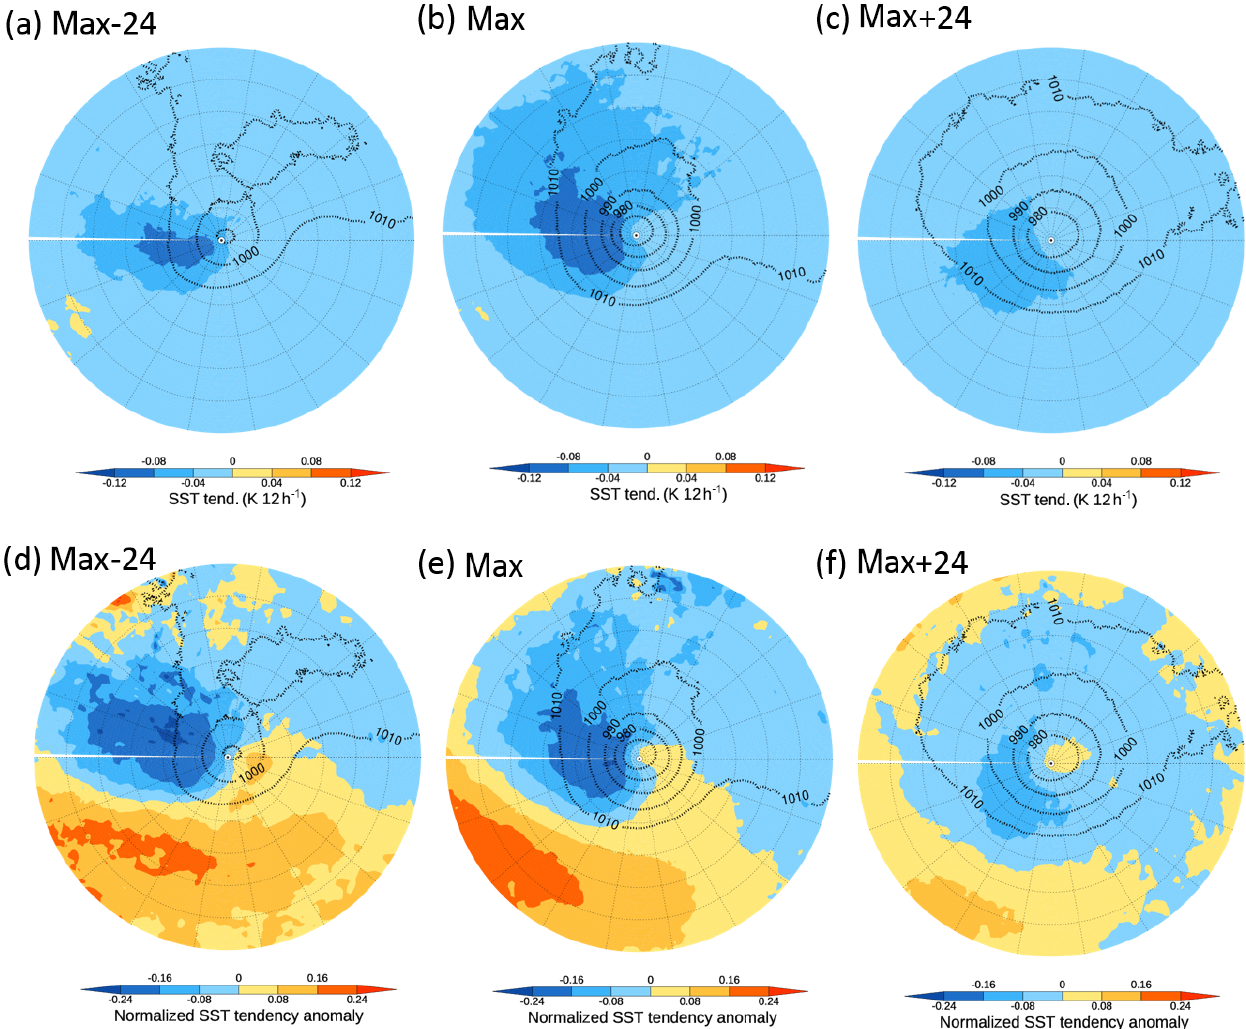
Figure 8. Evolution of cyclone-centred (a–c) (cid:49) SST Q (filled contours; K12h − 1 ), (d–f) normalized (cid:49) SST Q anomaly (filled contours) and N N mslp (black contours; hPa). Cyclones reach the centre of the domain (a, d) 24h before maximum intensity, (b, e) at maximum intensity and (c, f) 24h after maximum intensity. In (d) – (f) negative normalized (cid:49) SST Q anomalies indicate anomalously large SST cooling due to Q N , N and positive anomalies indicate anomalously small SST cooling, compared to climatology. (cid:49) SST Q per day for cyclones at different stages in their evo- N lution. The patterns of (cid:49) SST Q are similar to the patterns N of Q N (Fig. 7a–c), showing that the surface flux is the domi- nant variable in the cooling and that variations in mixed layer depth are less important. As for Q N , (cid:49) SST Q increases as N the cold front. The normalized (cid:49) SST Q anomalies are cal- N culated by subtracting the climatological (cid:49) SST TOT and di- viding by the standard deviation of (cid:49) SST TOT (Fig. 8d–f). (cid:49) SST Q is larger than the climatological mean behind the N cold front. However in this case the intense cyclones only reduce (cid:49) SST by up to 0.25 times the standard